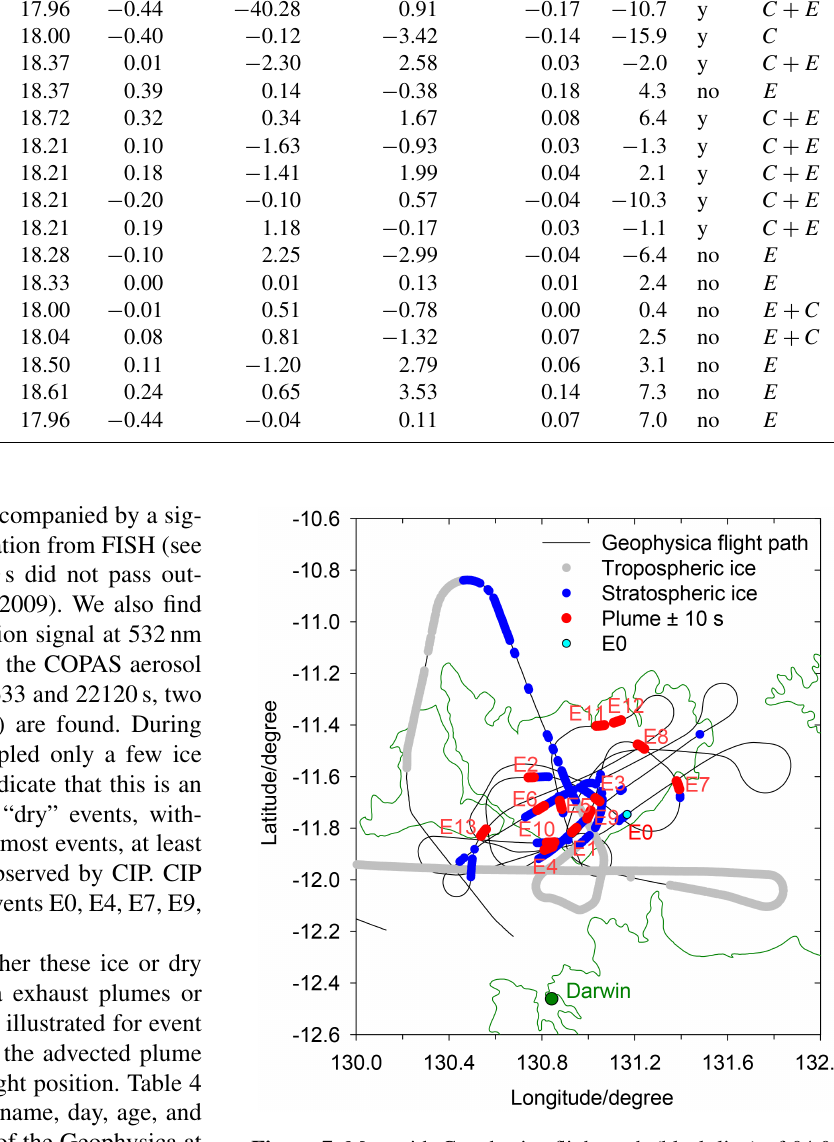
Figure 7. Map with Geophysica flight path (black line) of 04:00– 07:47UTC 30 November 2005. Colored symbols on the flight path identify periods with IWC >0.01gm − 3 in tropospheric cir- rus (gray), stratospheric cirrus (blue), and potential exhaust plume or contrails (red). Event positions are identified with “E” and event number. Darwin and the coast line are indicated in green